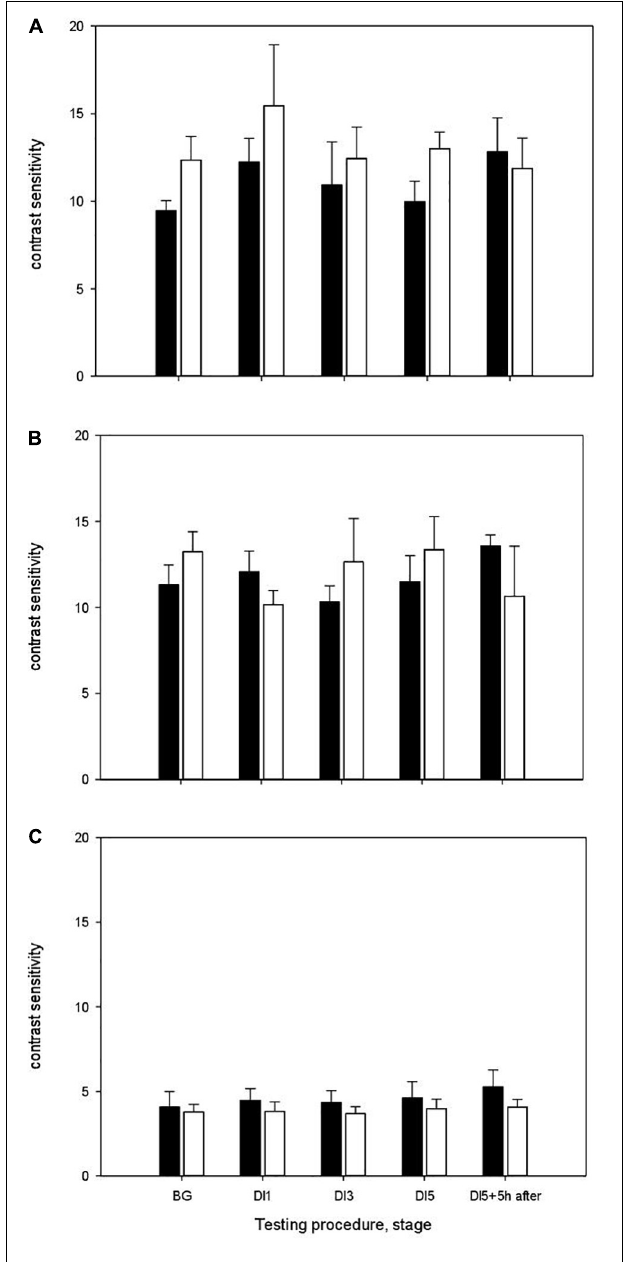
FIGURE 3 | The contrast sensitivity of the visual system in the DI with HFEMS (white bars) and without HFEMS (black bars). (A) The contrast sensitivity in the range of low spatial frequencies. (B) The contrast sensitivity in the range of medium frequencies. (C) The contrast sensitivity in the range of high frequencies. The ordinate shows contrast sensitivity, the inverse of the contrast threshold. All data are presented as mean ± standard